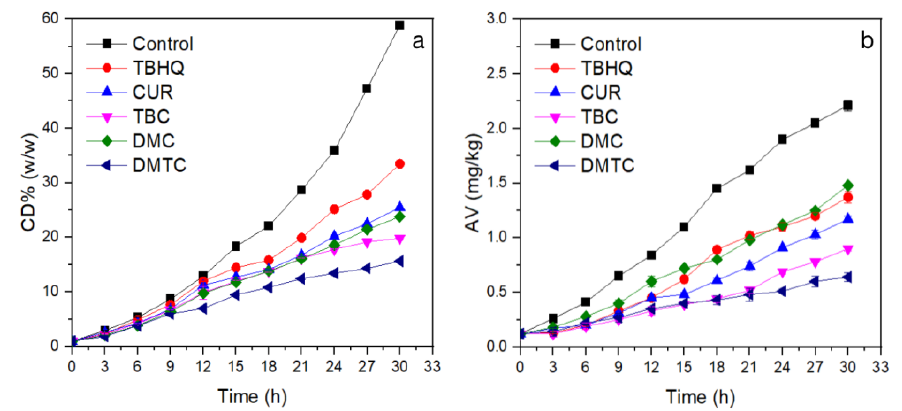
Figure 1. Changes in conjugated dienes (CD) and acid values (AV) of soybean oil spiked with or without antioxidants during deep frying at 180 °C. ( a ) CD, ( b ) AV. (n = 2)